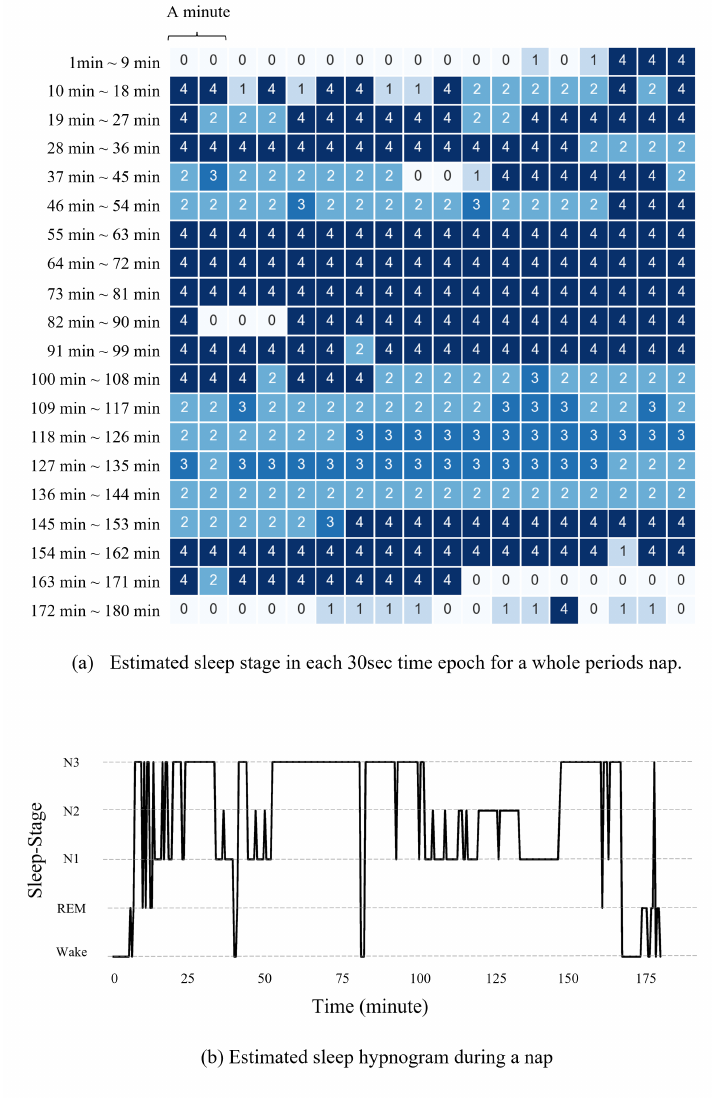
Figure 8. Estimaed hypnogram of one of the participants based on the sleep staging model. The esti- mation model architected by DeepSleepNet and trained by Wisconsin Sleep Cohort dataset. In ( a ), 0 is Wake, 1 is REM, 2 is N1, 3 is N2 and 4 is N3 sleep stage,